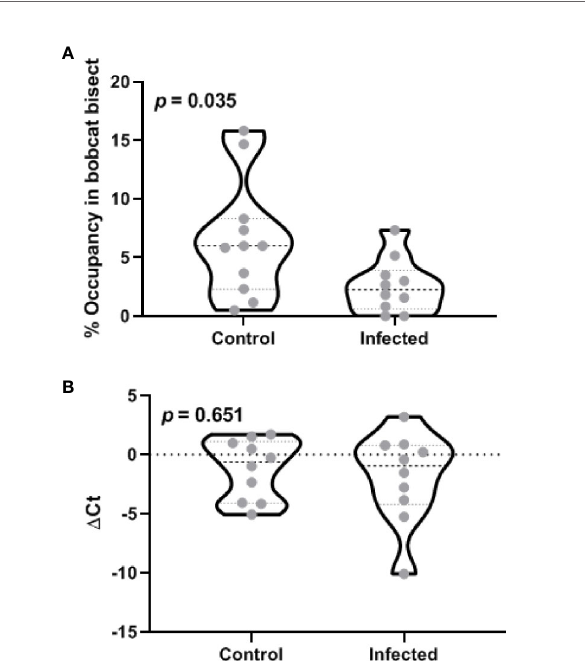
FIGURE 2 | Effects of testosterone supplementation within the posterodorsal medial amygdala on anxiety measured in an open- fi eld arena. The percentage of time spent in the center of the arena (A) and total number of sorties made during the trial (B) are depicted. Violin plots in these panels depict median and inter-quartile range along with raw values for all data points (n = 7 animals for vehicle and 11 for the testosterone-treated group). The p -values for inter-group differences are depicted in each